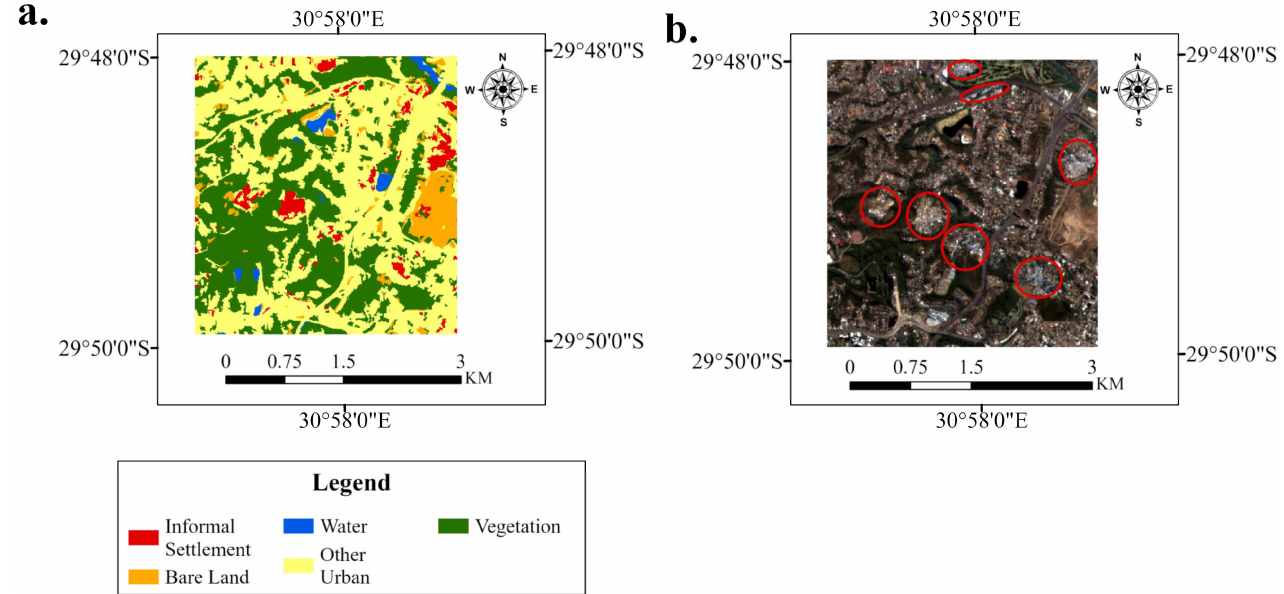
Figure 3. Comparison of results of informal settlements and LULC classification ( a ) and visual appearance of informal sample settlements on an RGB image ( b ) (circled in